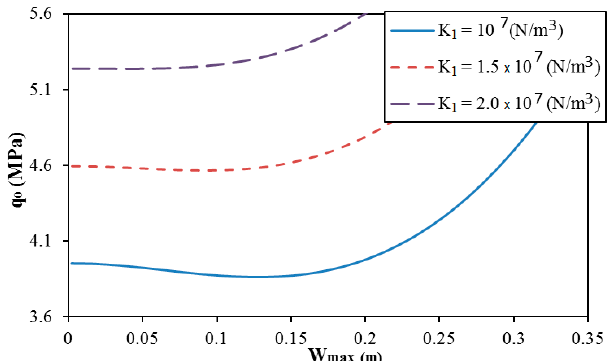
Figure 7. E ff ect of the Winkler modulus of the elastic foundation K 1 on the postbuckling curve of trapezoidal spiral corrugated sandwich FGM cylindrical shells ( e = 0.03 m , f = 0.015 m , δ = π /3, k = 1, N = 1, and K 2 = 5 × 10 4 N / m).